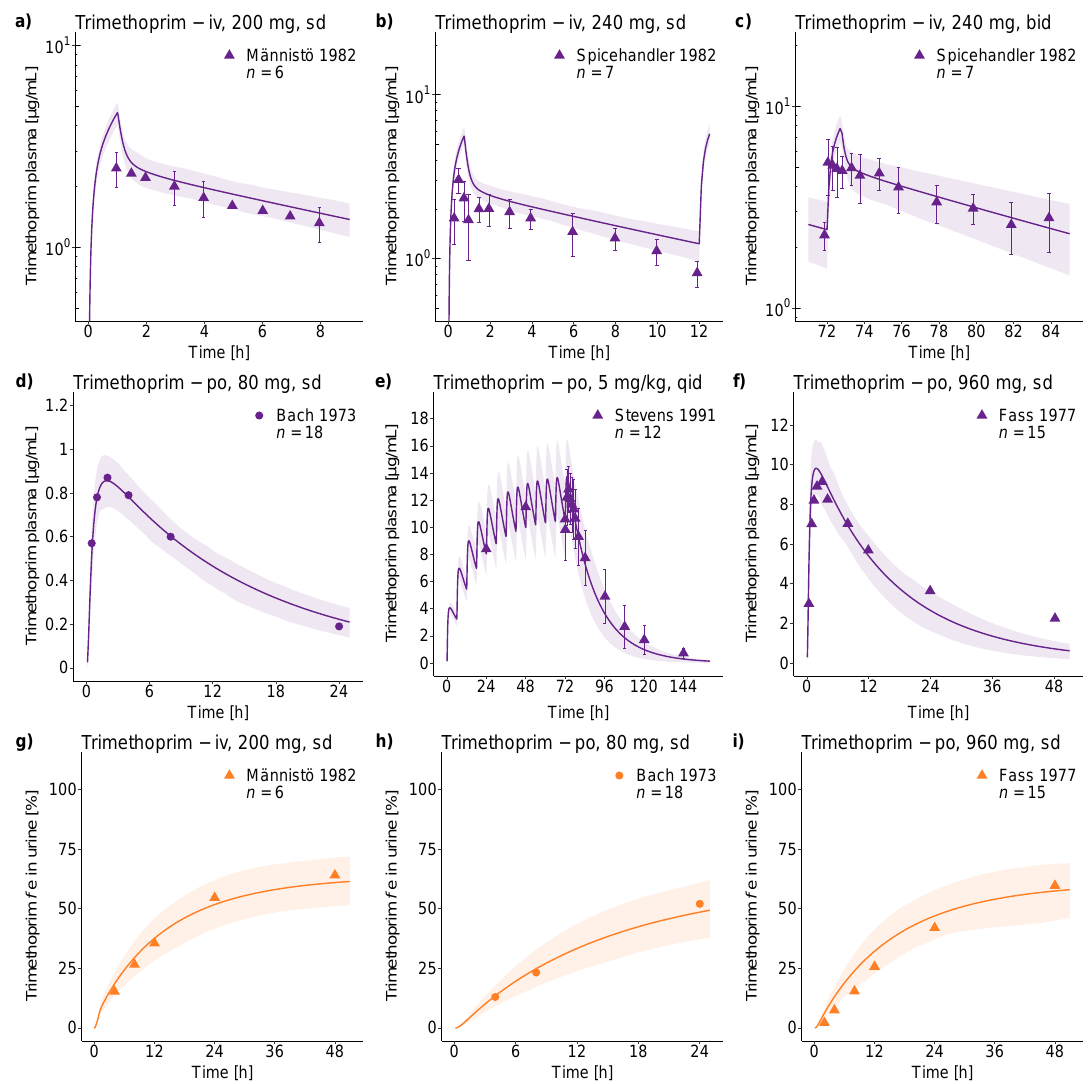
Figure 2. Trimethoprim in plasma and urine. Population predictions of trimethoprim ( a – f ) plasma concentration–time profiles and ( g – i ) fraction excreted unchanged in urine profiles compared to observed data [43,54,55,57,58] of representative intravenous and oral studies. Population prediction arithmetic means are shown as lines; the shaded areas illustrate the 68% population prediction intervals. Observed data are shown as triangles (training dataset) or dots (test dataset) ± standard deviation. Details on the study protocols and model simulations of all 66 clinical studies used for model building and evaluation are provided in the Supplementary Materials. bid, twice daily; f e in urine, fraction excreted unchanged in urine; iv, intravenous; po, oral; qid, four times daily; sd, single dose. Correlations of predicted with observed AUC last (97% within 2-fold) and C max values (98%